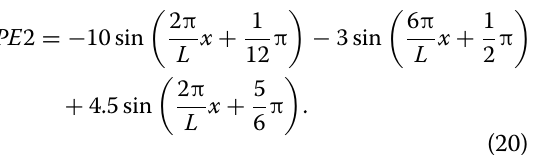
0.1 μm, b σ 0.2 μm, c = =